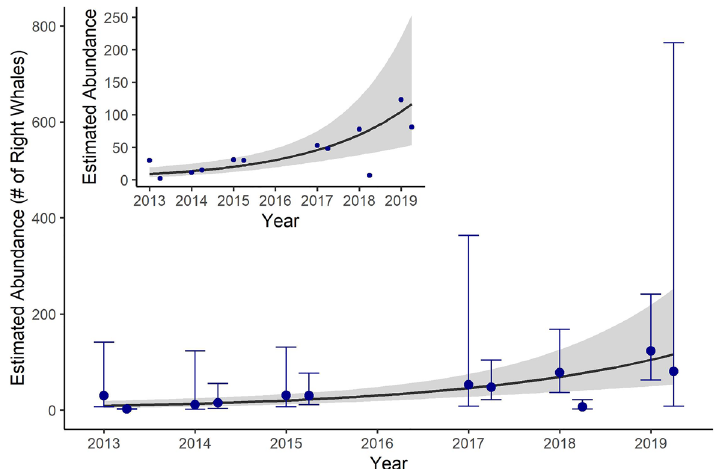
Figure 3. Trend in winter and spring right whale abundance estimated using a generalized linear model. Error bars represent 95% confidence intervals of abundance estimates; gray shading represents the 95% confidence interval around the trend line. Inset shows the same data and fit trend, without estimated abundance confidence